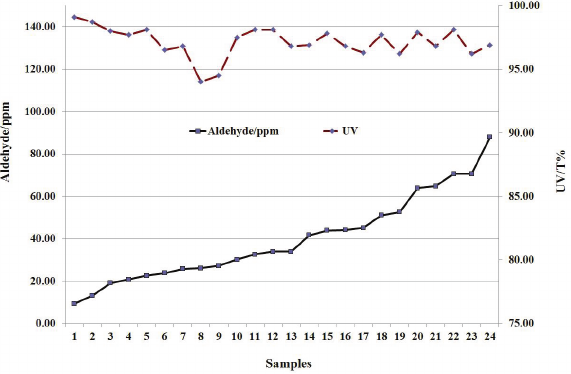
Figure 4: The effect of anion resin in ethylene glycol units, reducing the aldehyde in the water cycle output from the